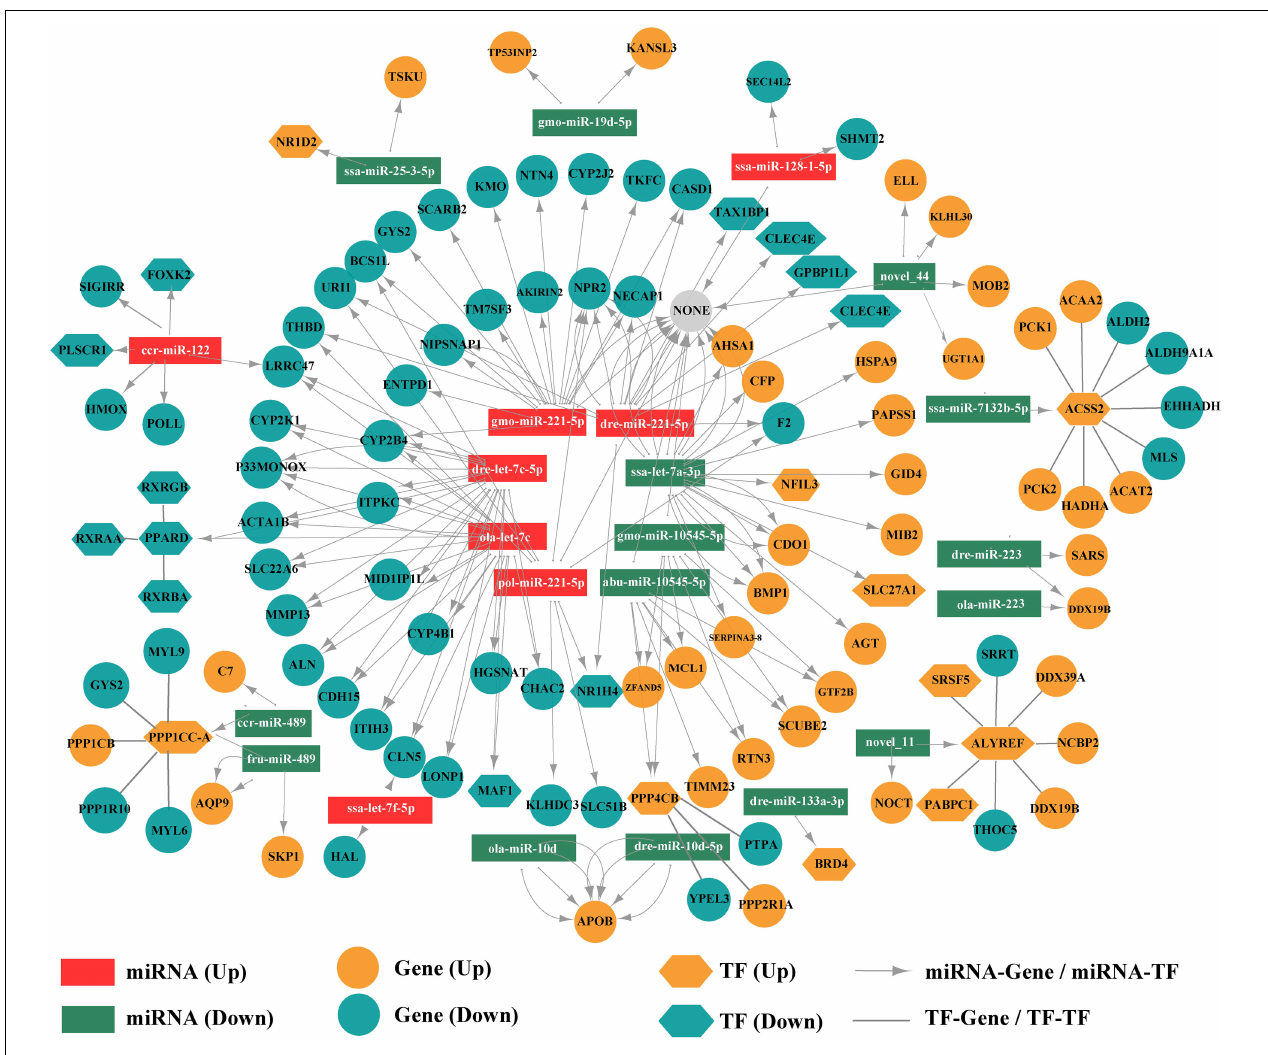
FIGURE 9 | Potential regulatory network based on the DE miRNAs, DE TFs, and